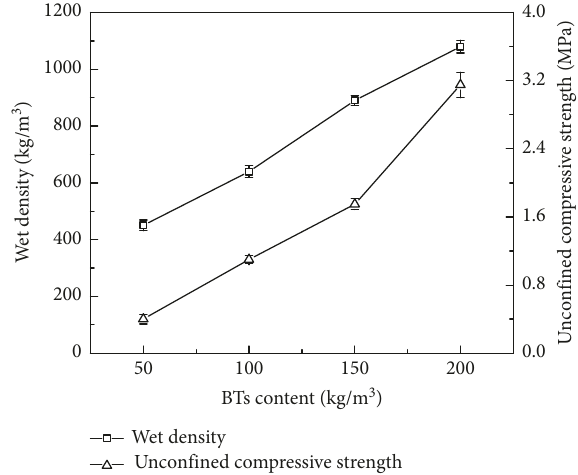
Figure 5: Influence of the BT content on the wet density and compressive strength of FMLSB.